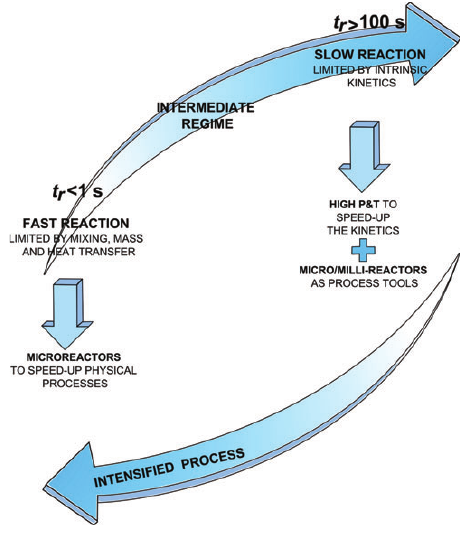
Figure 1 General strategy for process intensification (PI) of slow reactions.